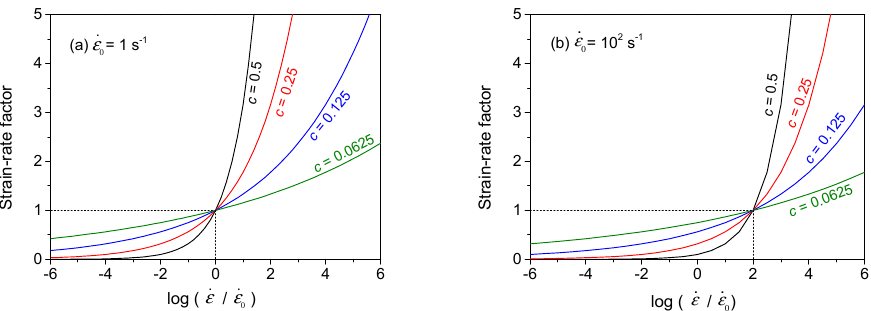
. . . ε / ε 0 ) when ε 0 is ( a ) 1 and ( b ) 10 2 s − 1 .